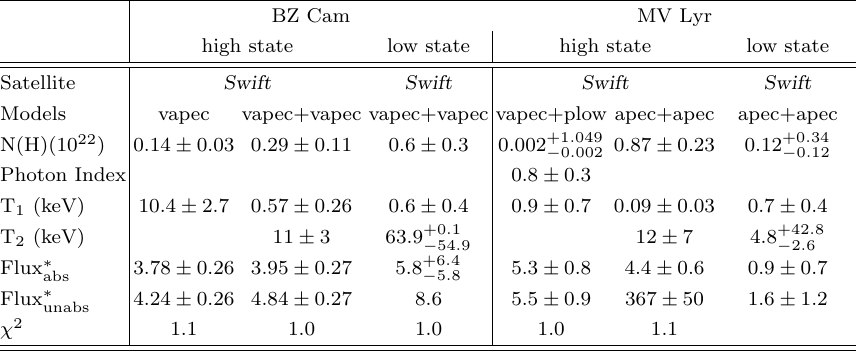
Table 1: Fitting models and parameters for BZ Cam and MV Lyr